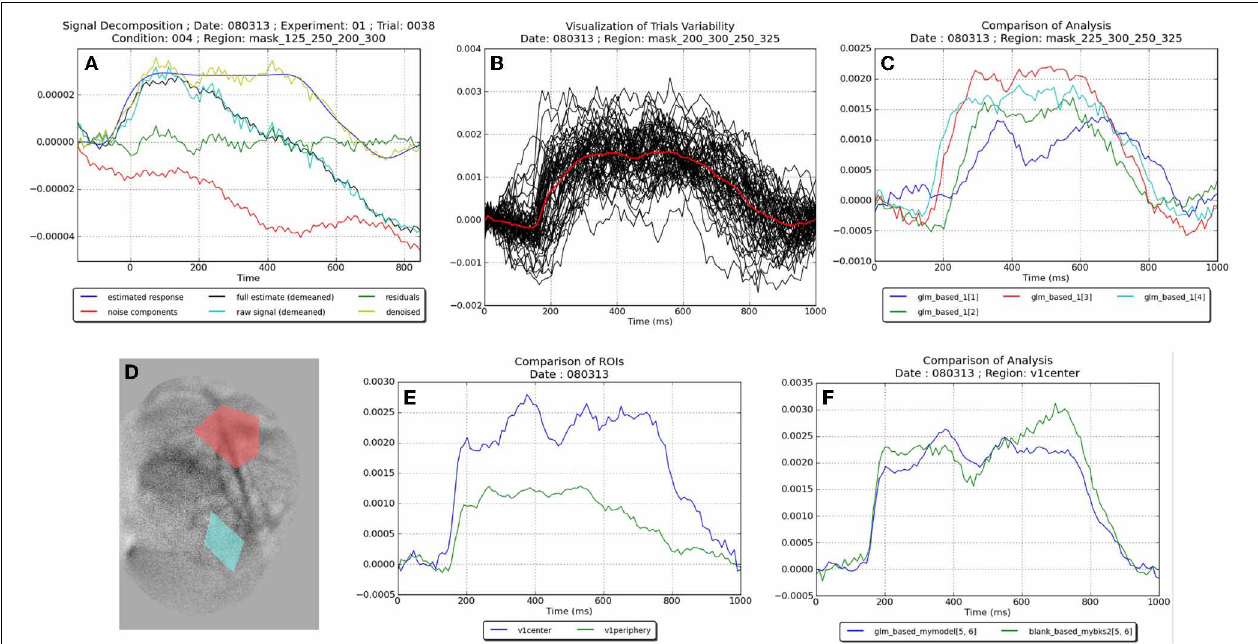
FIGURE 5 | Examples of figures produced by the different viewers and postprocessing routines on the VSDI dataset provided with Vobi One . (A) Illustration of the components (noise, neural response etc.) estimated by our linear model. (B) Denoised timecourses estimated with our linear model on all trials of a session. (C) Denoised timecourses obtained with four different contrasts of the visual stimuli. (D) Spatial map of the hearbeat contribution, with two regions of interest. (E) Denoised timecourses averaged in these two regions. (F) Comparaison of the denoised timecourses obtained with two analysis